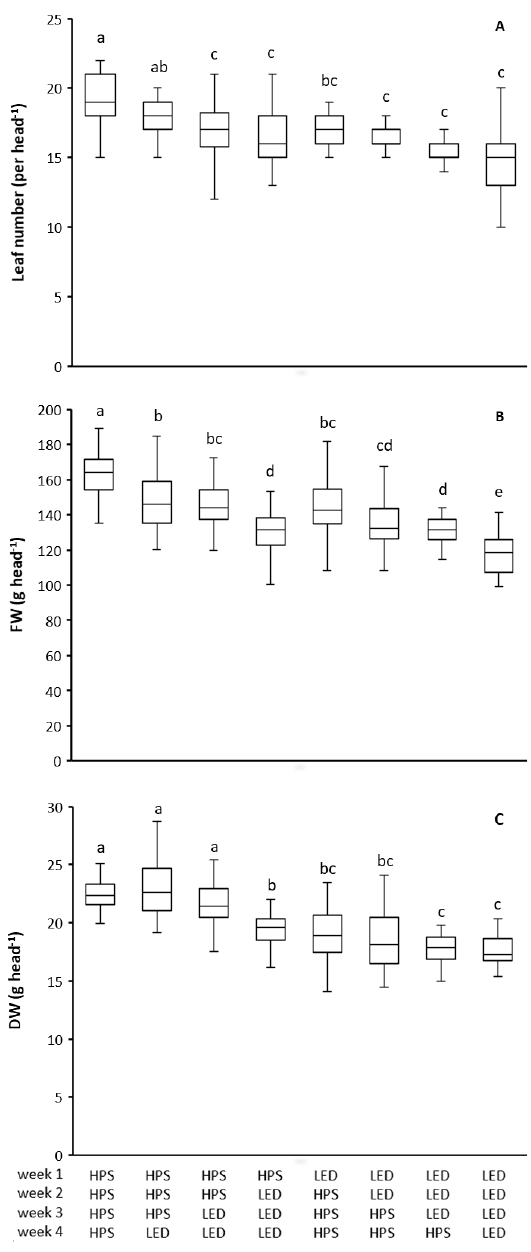
Fig. 1. Leaf number (A, Leaf number includes leaves ≥ 2 cm), fresh weight (FW, B) and dry weight (DW, C) of red winter lettuce ‘Carmoli‘ after four weeks growth period under different light treatments. Lettuce plants received either the whole growth period HPS or LED light, or different number of weeks HPS and LED light. Plant measurements represent individual measurements of 40 plants for each light treatment (four repetitions consisting of ten individual plants each). Differences between the light treatments are based on pairwise t test, and letters indicate significant differences at the p = 0.05